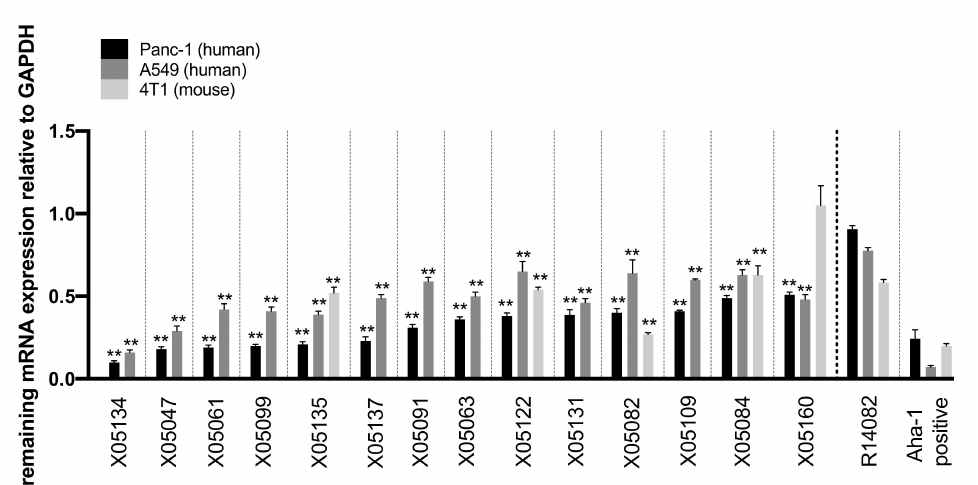
Figure 2. 14 most active ASO candidates against TGFBR2 after gymnotic delivery. Remaining TGFBR2 mRNA after 72 h of incubation with di ff erent ASOs as measured in a bDNA assay ( n = 4) relative to the reference gene GAPDH. TGFBR2 expression was normalized to respective PBS-treated control cells. Panc-1 cells were treated with 5 µ M, A549 and 4T1 cells with 7.5 µ M of each ASO. Statistics